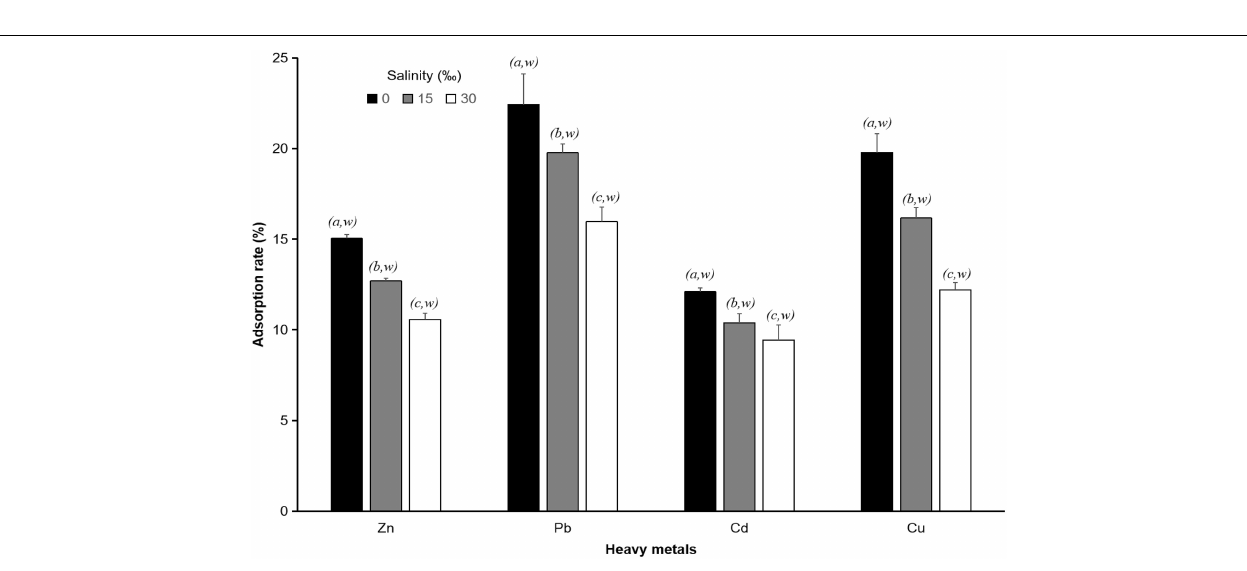
Frontiers in Marine Science |